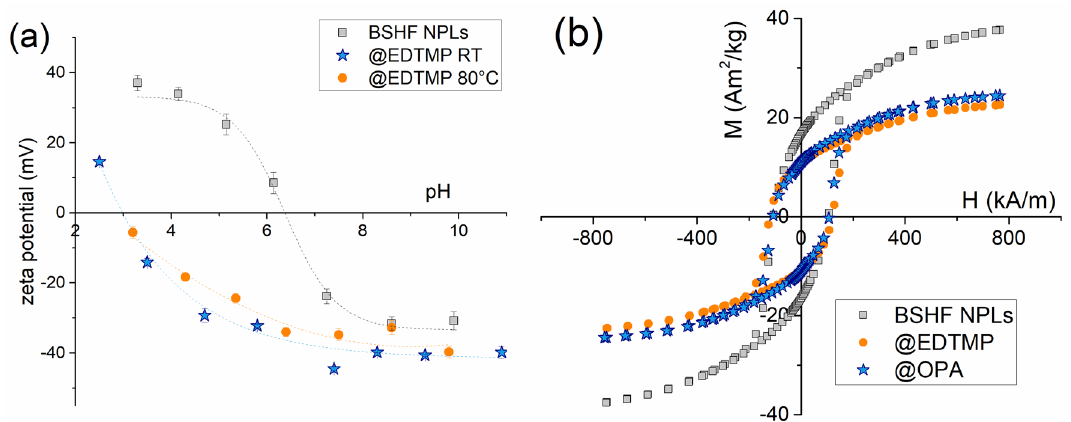
Figure 3. ( a ) Zeta-potential behaviour of the BSHF NPLs aqueous suspensions, and ( b ) magnetic hysteresis loops of the core and coated BSHF NPLs. The Ms values are given in Table 1. The lines in panel ( a ) are a guide to the eye.